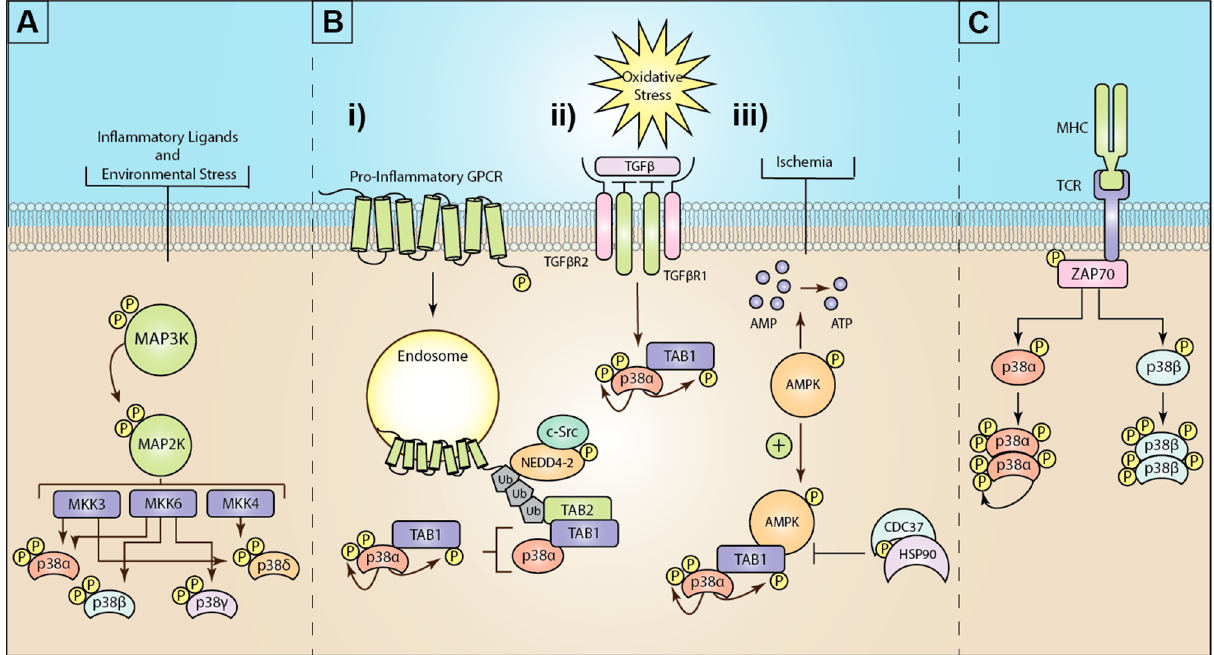
Figure 1. Mechanisms of mitogen-activated protein kinase (MAPK) p38 activation: ( A ) Inflammatory ligands and envi- ronmental stress trigger the activation of a three-tiered kinase cascade. Environmental or inflammatory ligands induce the activation of MAP3Ks through a complex array of different mechanisms. MAP3Ks then activate the critical MAP2Ks, MKK3, MKK6, or (less commonly) MKK4. These MAP2Ks can then differentially activate the four isoforms of p38 ( α , β , γ , and δ ). ( B ) The known mechanisms for atypical p38 signaling are (i) GPCR stimulation triggers G-protein dependent c-Src phospho-activation of the E3 ubiquitin ligase neural precursor cell expressed developmentally downregulated 4-2 (NEDD4-2). GPCRs recruit and are ubiquitinated by NEDD4-2. K63 ubiquitin chains recruit the ubiquitin-binding adaptor protein TAK1-binding protein 2 (TAB2). In turn, TAB2 then recruits TAB1, which binds and induces autophosphorylation of p38 α . (ii) Oxidative stress triggers TGF β activation, which drives TAB1 and p38 activation, although the exact mechanism is unclear. (iii) Ischemia or hypoxia events drive activation of AMP-activated protein kinase (AMPK), which in turn promotes the formation of the TAB1-p38 α complex and p38 α autophosphorylation. This process is negatively regulated by the heat shock protein 90 (HSP90)-Cdc37 complex. ( C ) T-cell receptor (TCR) ligation to major histocompatibility complex (MHC) drives intracellular activation of the src-family zeta-chain-associated protein kinase 70 (Zap70). Zap70 phosphorylates p38 at tyrosine 323, enabling autophosphorylation of p38 α , or β